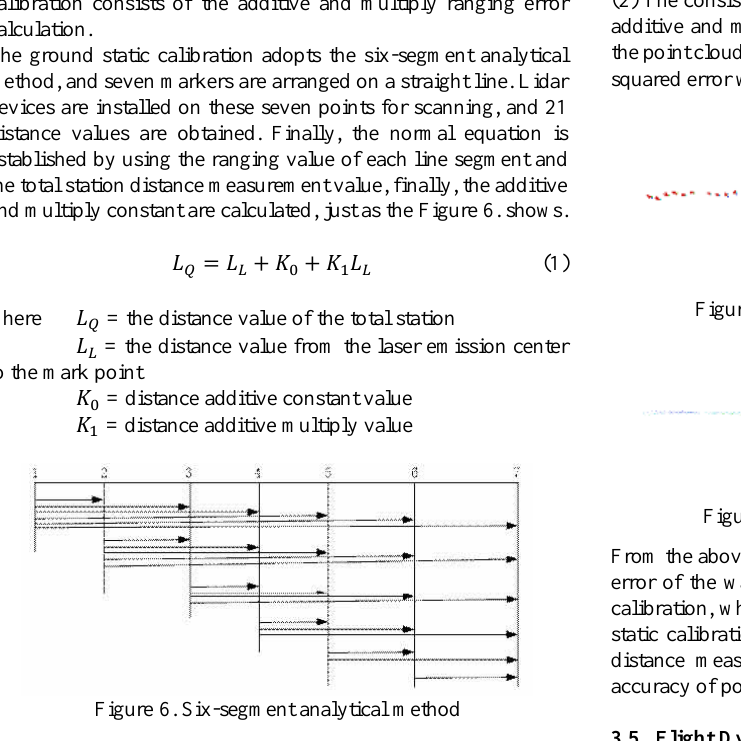
Figure 6. Six-segment analytical method